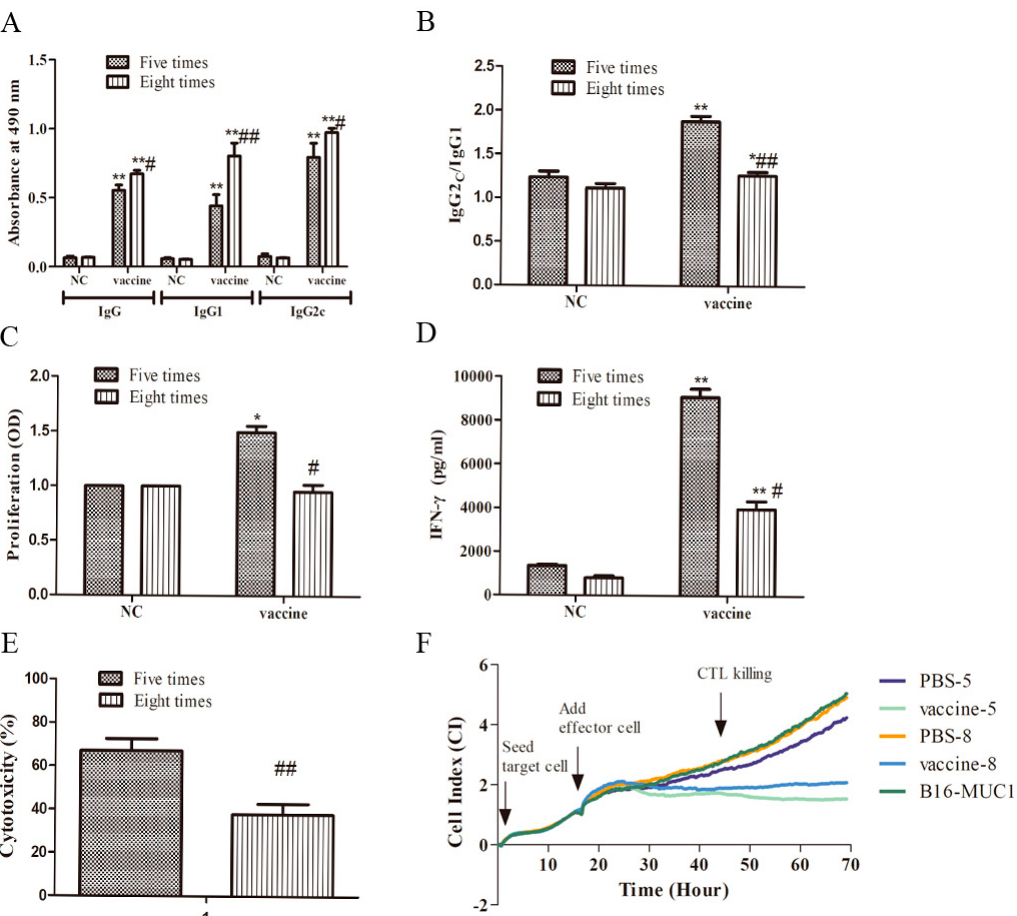
Figure 2. The e ff ect of immunization cycles on the recombinant MUC1-MBP vaccine-induced MUC1-specific humoral and cellular immune responses in the preventive mouse model. ( A – F ) Mice ( n = 5) were immunized with vaccine five or eight times at 7-day intervals, and then subcutaneous injected (s.c.) with 5 × 10 5 B16-MUC1 melanoma cells one week after the final immunization. The mice were euthanized 15 days after tumor inoculation, and the serum was collected for the MUC1-specific antibody assay. Splenocytes from each group were stimulated in vitro with a specific MUC1 peptide (20 µ g / mL) for five days. Then, cell proliferation was measured with the WST-1 kit and cytokine activity was detected by enzyme-linked immunosorbent assay (ELISA). To evaluate cytotoxic T lymphocyte (CTL) killing activity, splenic mononuclear cells from immunized mice stimulated with MUC1 peptide in vitro were used as e ff ector cells, and a B16 mouse melanoma cell line stably expressing human MUC1 was established as target cells. MUC1-specific CTL responses were detected by xCELLigence real-time cell analyzer (RTCA) S16 ( A ) MUC1-specific IgG, IgG1, and IgG2c levels in the sera of the immunized mice were determined using ELISA ( B ) Serum IgG2c / IgG1 ratio. ( C ) Lymphocyte proliferation was measured by the WST-1 assay. ( D ) IFN- γ secretion was measured by ELISA. (E–F) MUC1-specific CTL killing activity was measured by an RTCA. ( E ) CTL killing activity: cytotoxicity (%) = (1 − CI (vaccine group) / CI (NC group)) × 100%. ( F ) The dynamic change in the cell index (CI); PBS-5 and PBS-8 represent e ff ector cells immunized with PBS five and eight times immunizations, respectively; vaccine-5 and vaccine-8 represent e ff ector cells immunized five and eight time immunizations, respectively; B16-MUC1 only represents target cells and no e ff ector cells. * p < 0.05, ** p < 0.01 vs. the NC group. # p < 0.05, ## p < 0.01 vs. the group immunized five times.